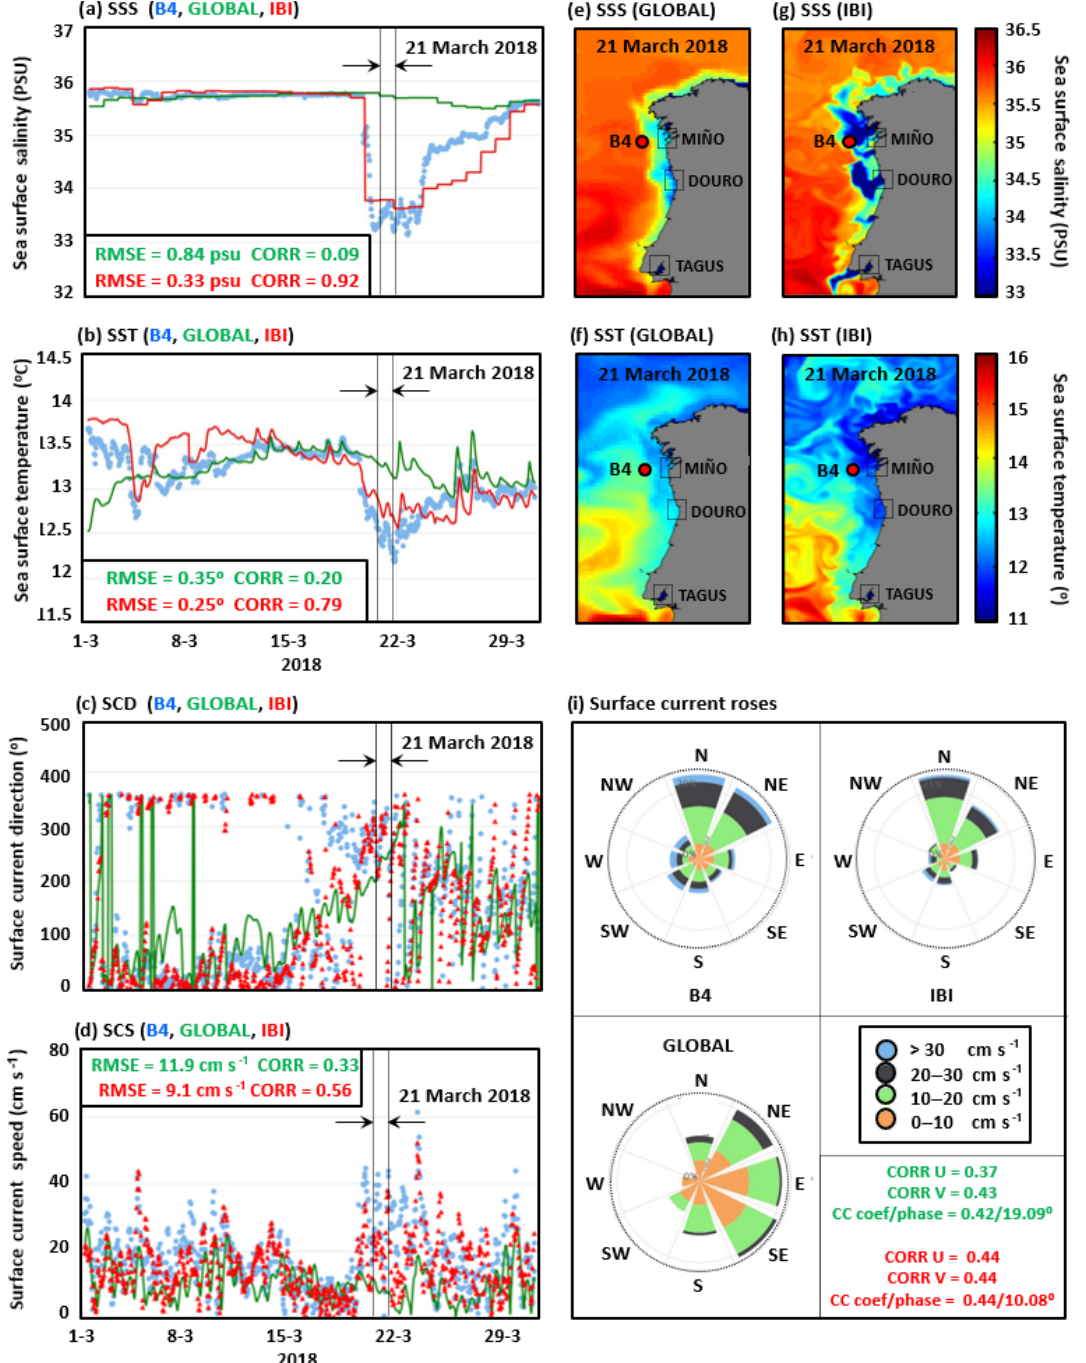
Figure 6. (a–d) Monthly inter-comparison (March 2018) between GLOBAL (green line), IBI (red line / red triangles) and B4 buoy (blue dots): sea surface salinity (SSS), temperature (SST), current direction (SCD), and current speed (SCS); (e, f) daily maps of SSS and SST derived from GLOBAL outputs for the 21 March. Red filled dot represents B4 buoy location; (g, h) daily maps of SSS and SST derived from IBI outputs for the 21 March; (i) monthly surface current roses. Monthly skill metrics derived from model–observation comparisons are